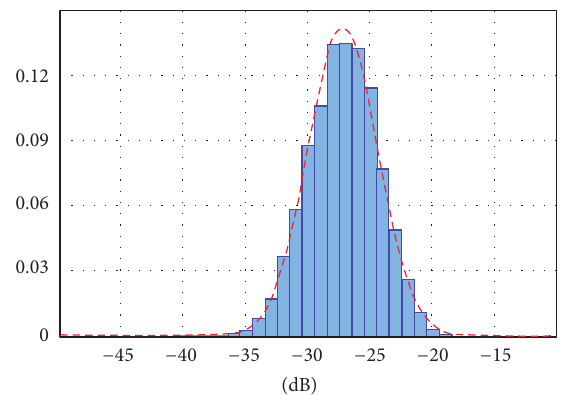
Figure 22: Histogram of the relative frequency of 𝐹( Z 𝑈 ) in dB, for = 1 %, obtained with 10000 samples, and normal distribution 𝜎 𝐶 having the same mean and the same standard deviation (dashed curve).